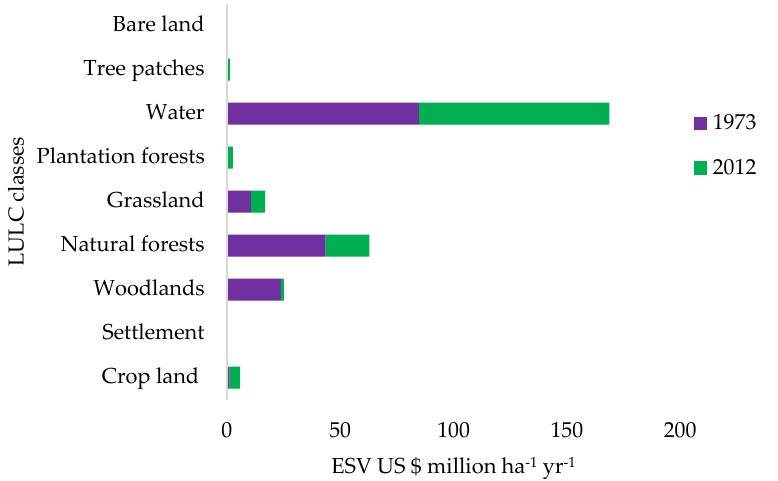
Figure 12. ESVs from 1973 to 2012 in Munessa-Shashemene, Ethiopia (Source of data: Kindu et al. [1], but figure done by authors).